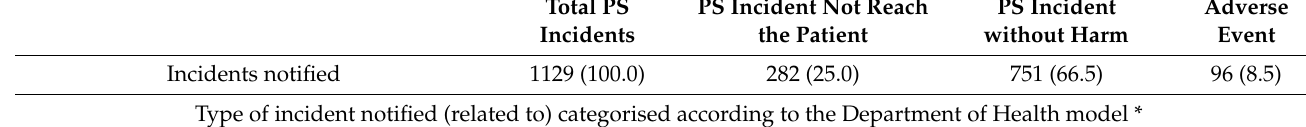
Table 3. Distribution of type of incidents notified categorised according to the Catalan Department of Health model.